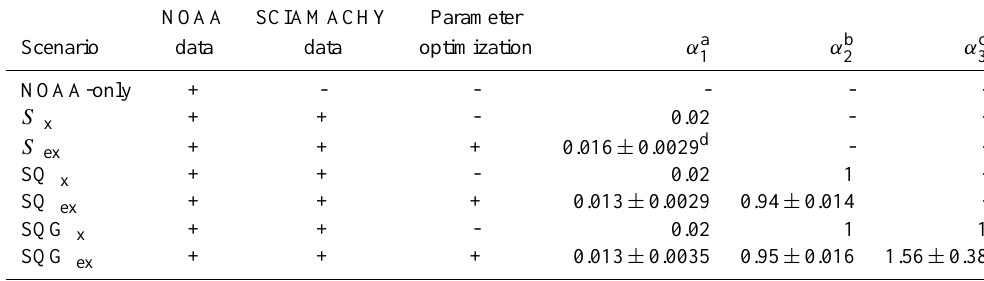
Table 3. Inverse modelling scenarios and bias